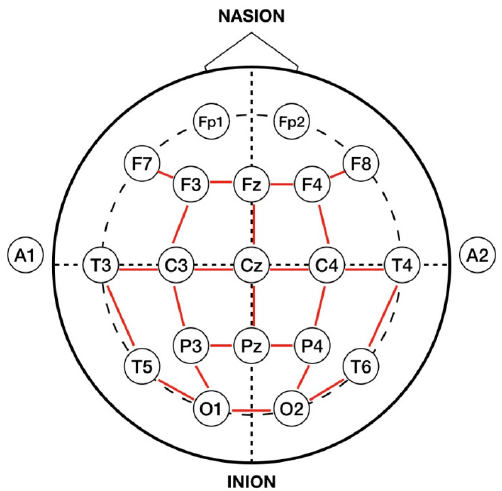
Figure 1. EEG signals were collected from 23 bipolar channels based on the 10–20 international